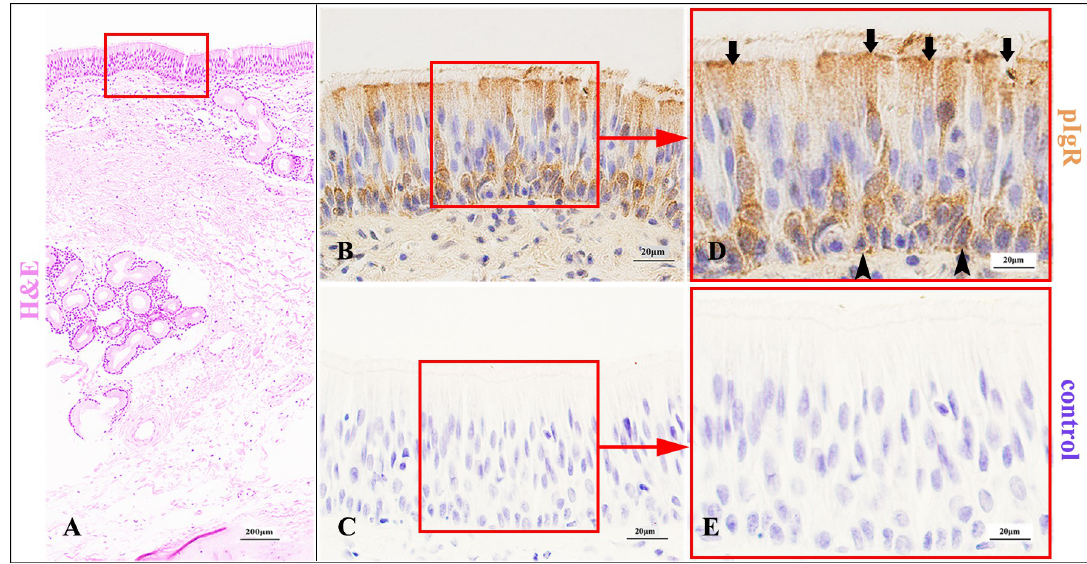
Fig 2. pIgR expression characteristics in the main bronchial epithelium of Bactrian camels.